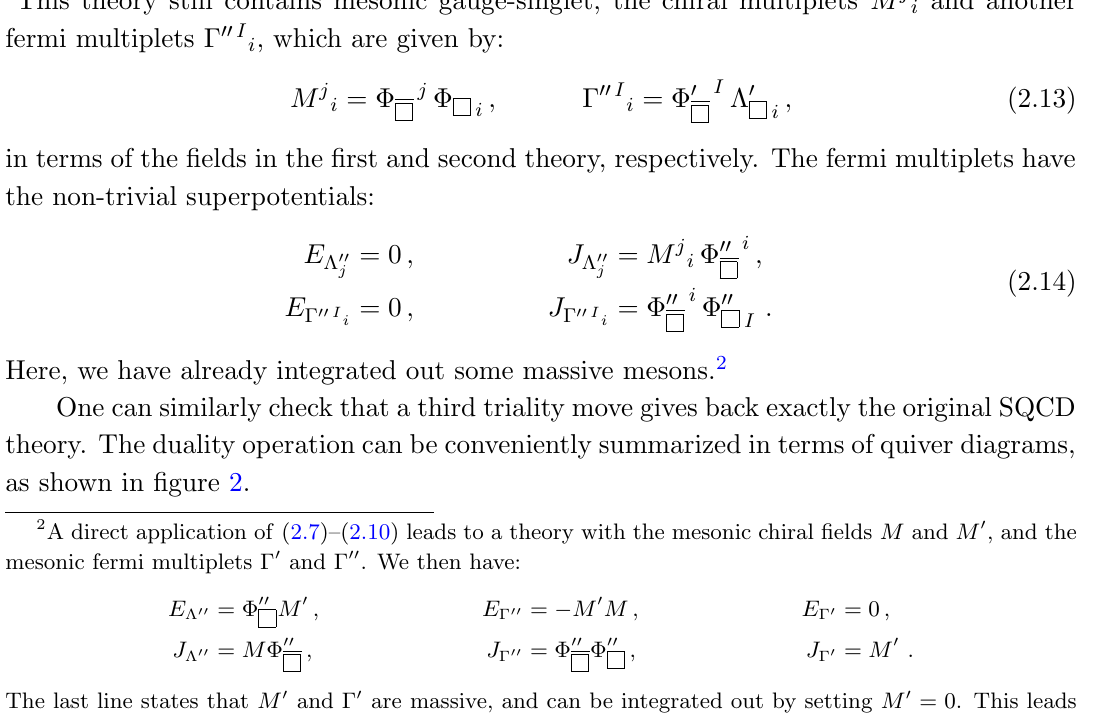
Figure 2 . The triality cycle for 2 d representation of U( N c ) are omitted to avoid